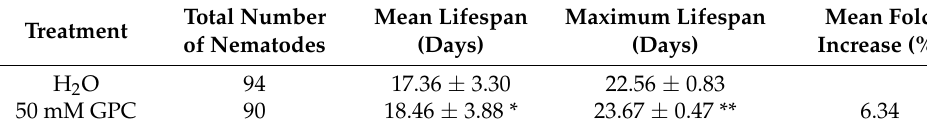
Table 2. Effect of GPC on the oxidative stress resistance in C. elegans . Total Number Treatment of Nematodes